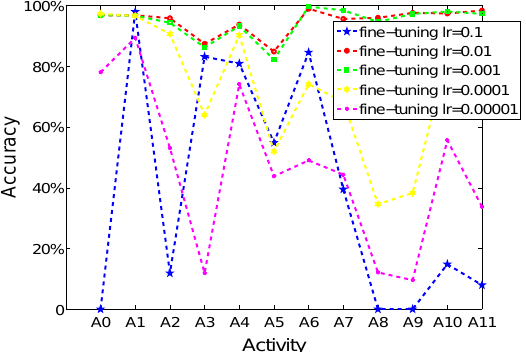
Figure 6. The recognition performance of each activity when using different fine-tuning learning rates (iterations is set to 200; number of hidden layer is set to 2; pretraining learning rate is set to 1 × 10 − 7 ). (d)